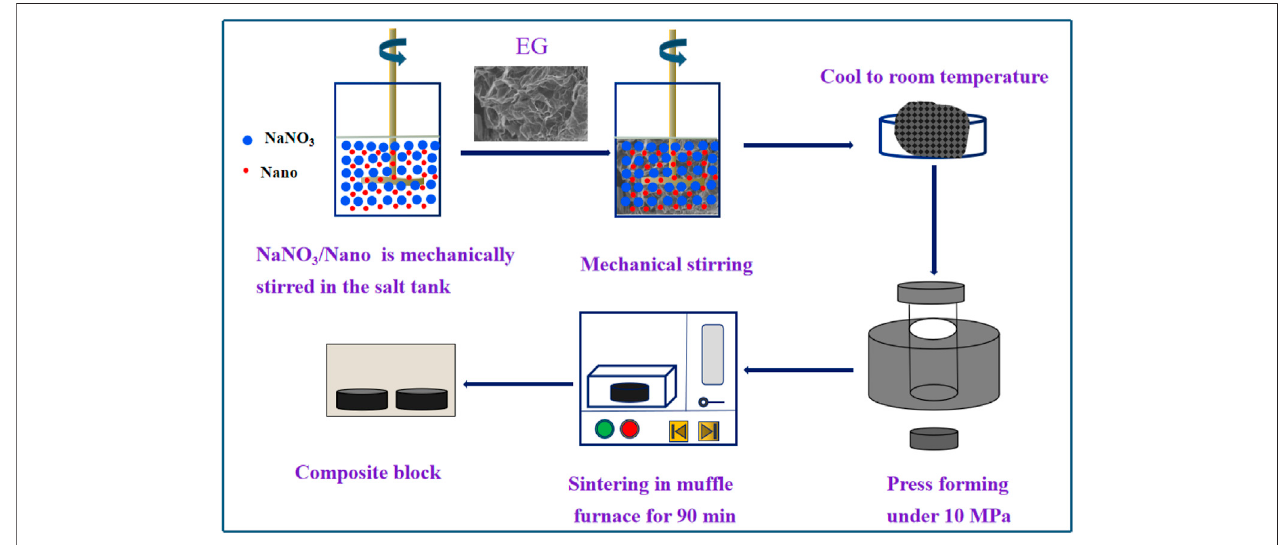
FIGURE 2 | The composite preparation process with mechanical dispersion method.